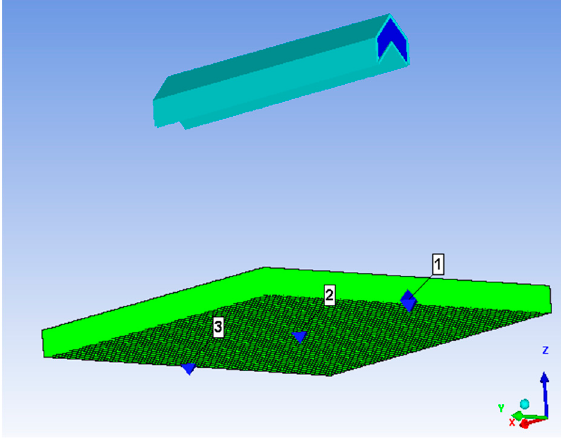
Figure 13. Numerical simulation model of linear charge-shaped jet cutting.